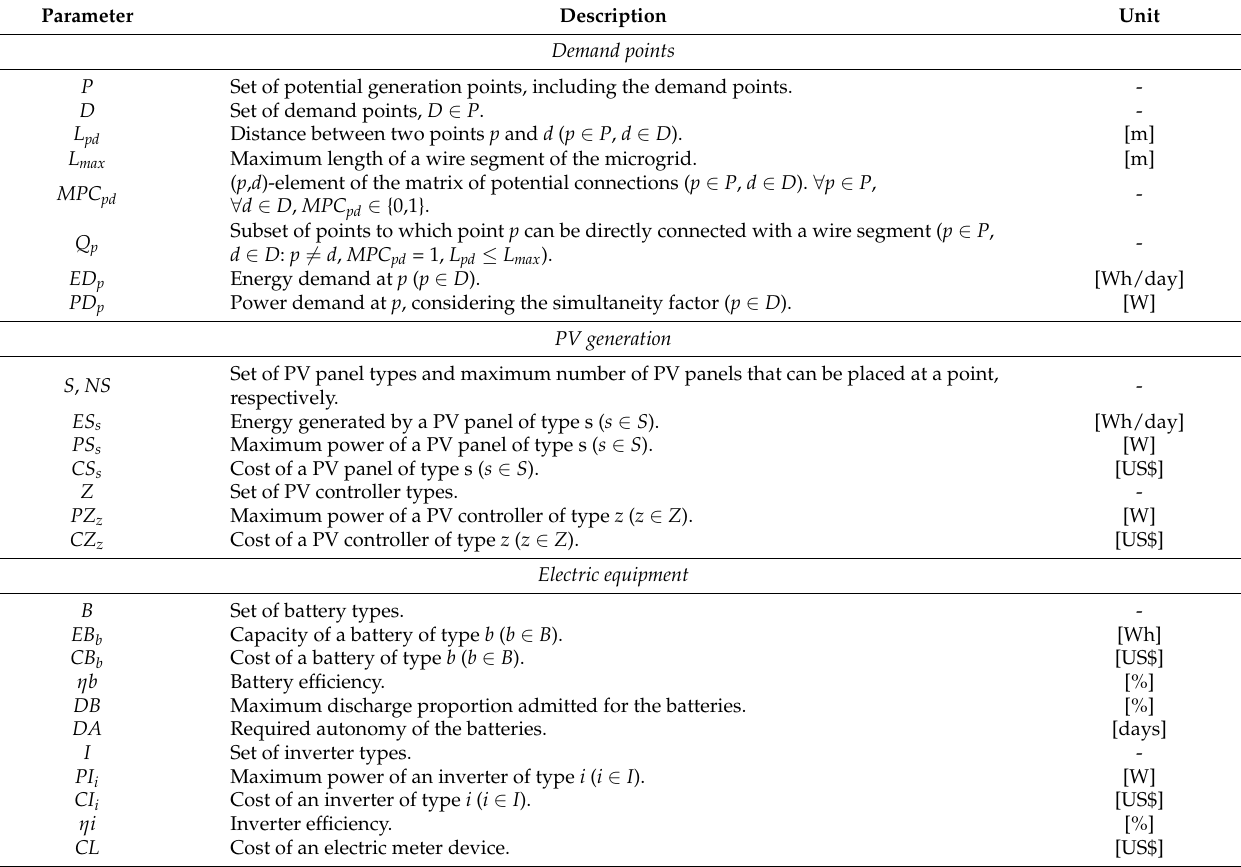
Table 2. Parameters of the mathematical